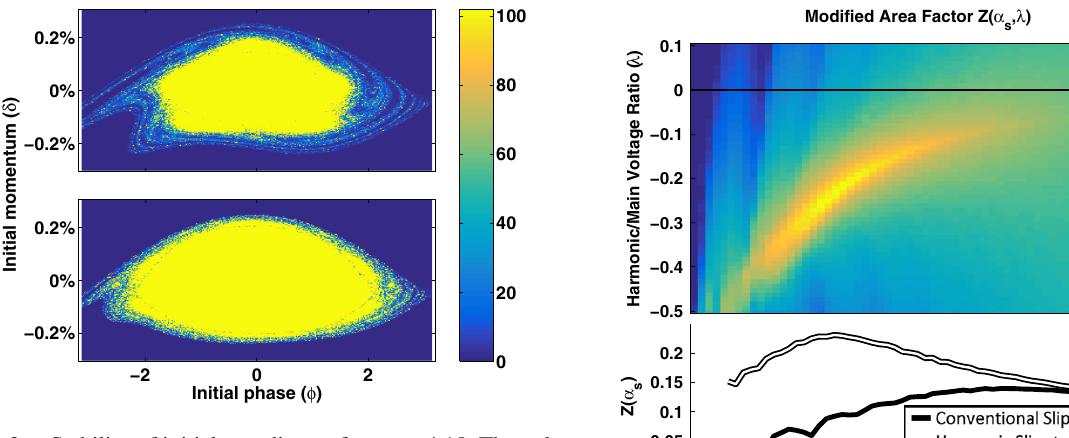
FIG. 2. Stability of initial coordinates for α s ¼ 4 . 18 . The color shows the number of synchrotron periods a test particle survives before it is lost. The top plot shows conventional slip stacking and the bottom plot shows harmonic slip